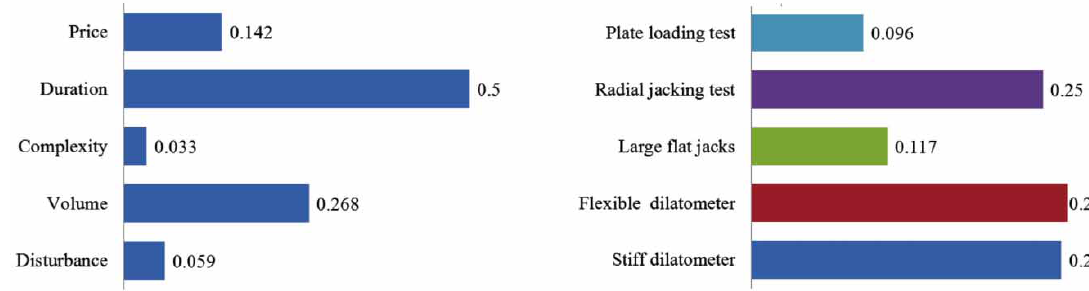
Fig. 9. Sensitivity analysis (cid:1) increasing the weight of the criterion Duration to